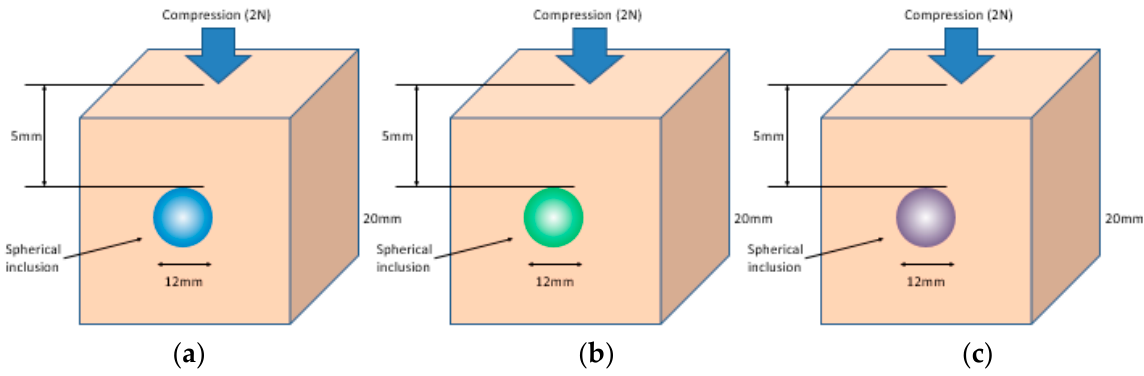
Sensors 2023 , 23 , x FOR PEER REVIEW 20 of 28 Figure 18. Tactile images of three different hardness values embedded in the phantom: ( a ) 110 kPa of tissue included, ( b ) 80 kPa of tissue included, and ( c ) 50 kPa of tissue included.